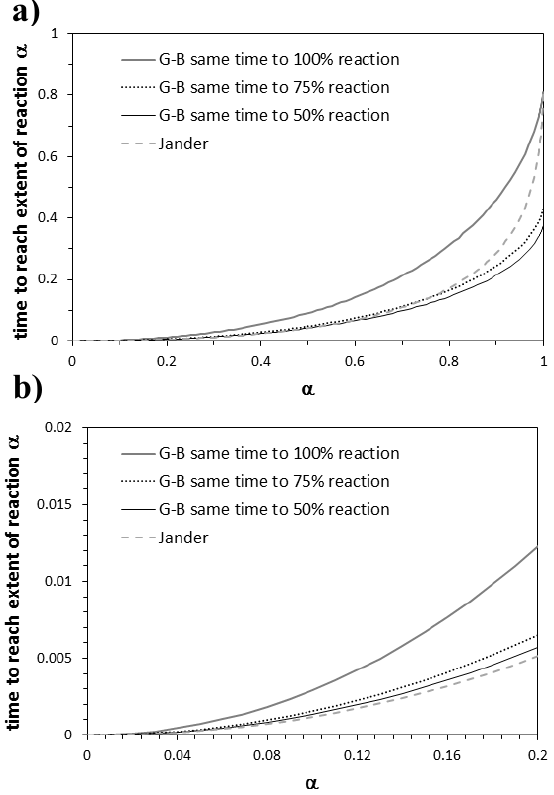
Figure 3. Comparison of the Ginstling-Brounshtein (G-B) and Jander equations: a) normalising each model to give constant times to 50%, 75% and 100% extents of reaction; b) expansion of a) in the region of low α